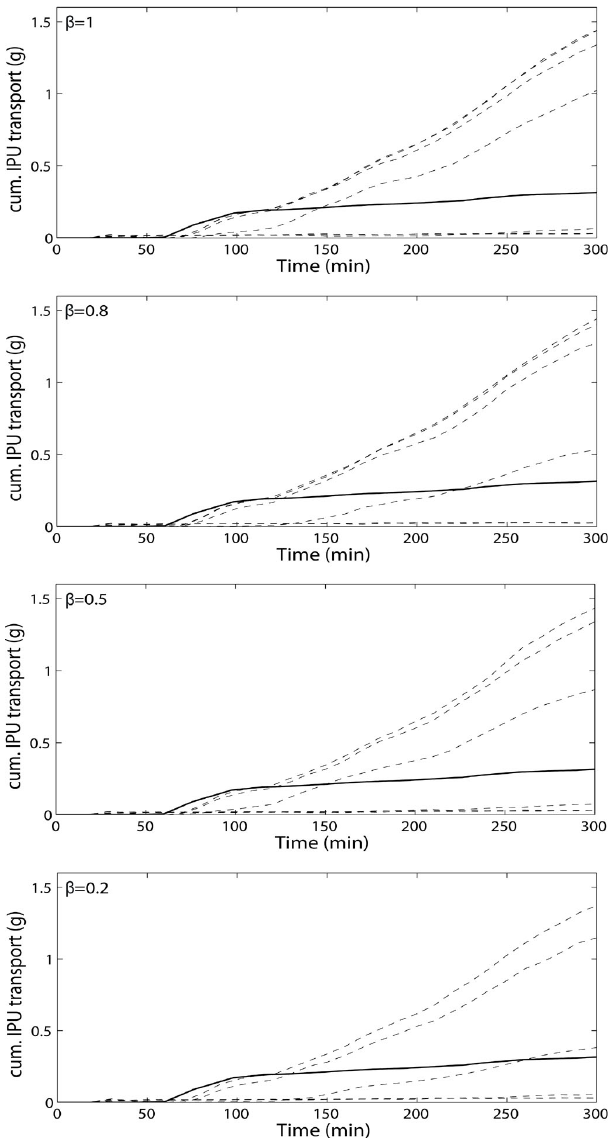
Fig. 8. Cumulated IPU loss plotted against simulation time for dif- ferent parameterisations of the Freundlich isotherm. The solid line presents the observed IPU leaching, the dashed lines model runs with different parameterisation of the Freundlich parameters. Ev- ery plot includes eight model realisations with a fixed value for the Freundlich exponent β and varied values for the Freundlich coeffi- 8